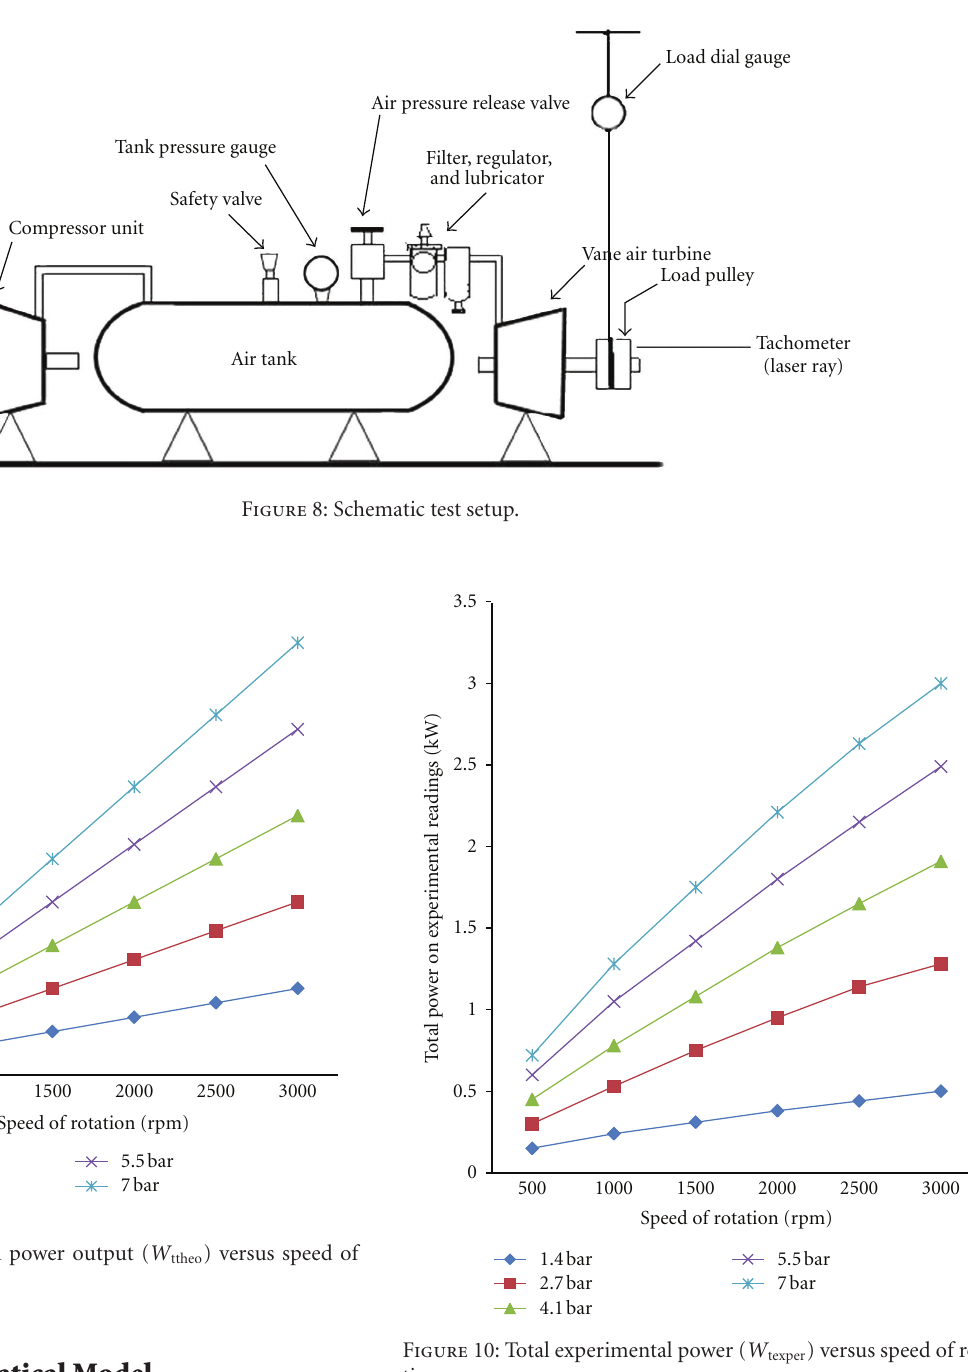
Figure 10: Total experimental power ( W texper ) versus speed of rota-